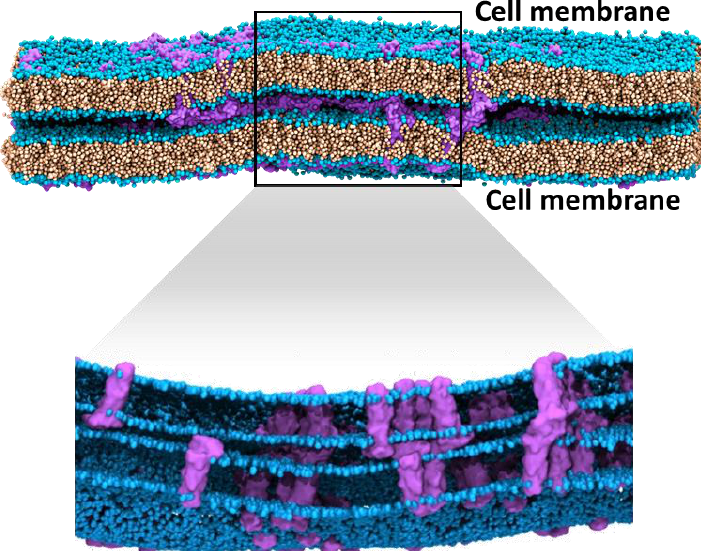
Figure 10. Claudin-5 assembly in two adjacent membranes. A 20 µs snapshot of claudin-5 (purple) trans and cis assembly in a coarse gained MD simulation. The zoomed-in view shows the interacting claudins embedded in the membrane (lipid head groups (blue); lipid tails (light brown). Water and ions in the system are not shown for